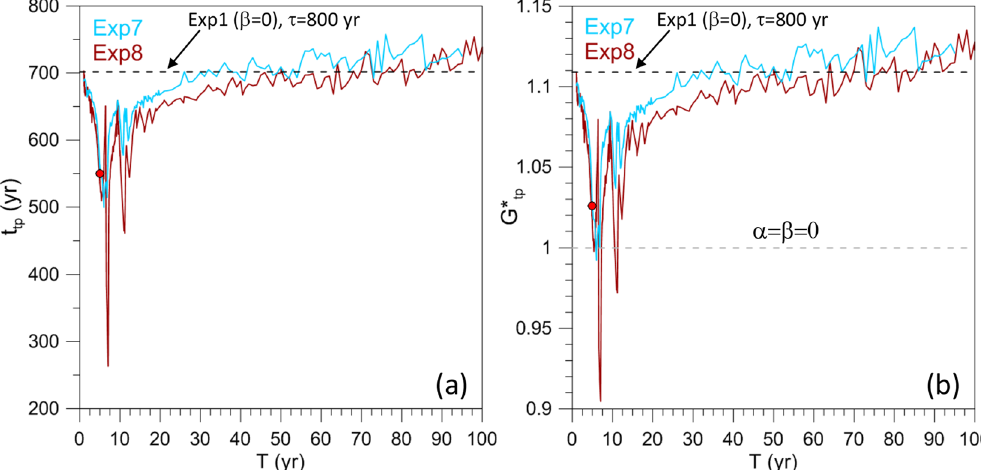
Figure 10. Dependence of the TP on period T in Exp7 and Exp8. ( a ) TP timing t tp versus period T . The horizontal dashed line indicates the value corresponding to Exp1 for τ = 800 year. ( b ) G ∗ tp versus T . Black dashed line as in panel ( a ), while the gray dashed line corresponds to the critical value of the autonomous system. The red filled circles in both ( a ) and ( b ) indicate the value that is common to Exp7 and